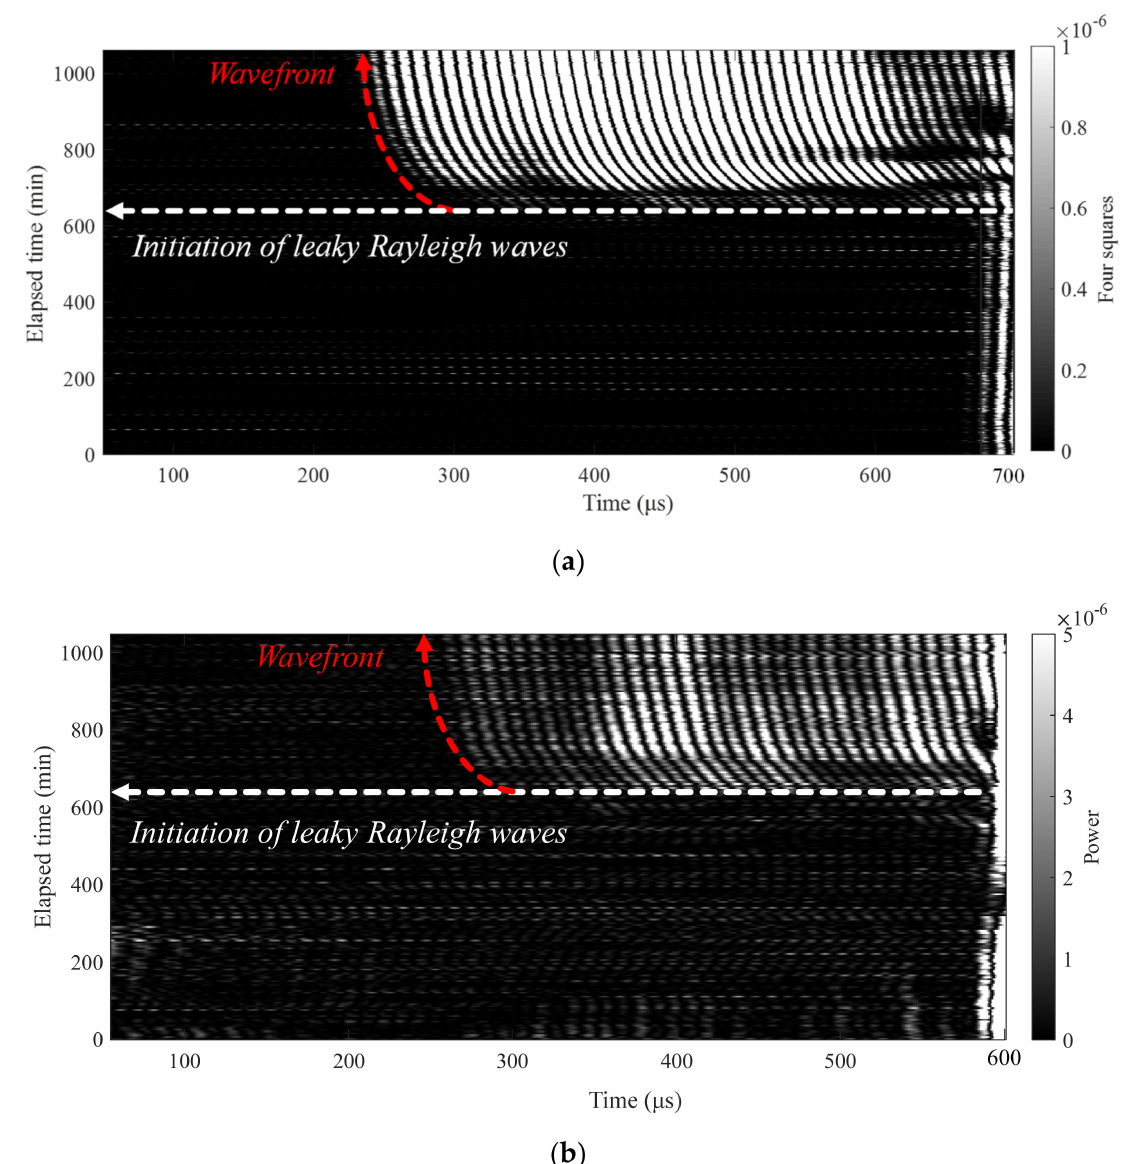
Figure 6. B-scan images obtained from the ( a ) wired system, and ( b ) wireless system. Despite the good agreement in the leaky Rayleigh wave initiation time and wave-front development, the wired and wireless measurement systems show differences in signal- to-noise level in the B-scan images (Figure 6). The signal-to-noise ratio (SNR) after the leaky Rayleigh wave initiation time is 20.9 dB and 11.3 dB for the wired and wireless measurement systems, respectively. We believe that different power supply systems